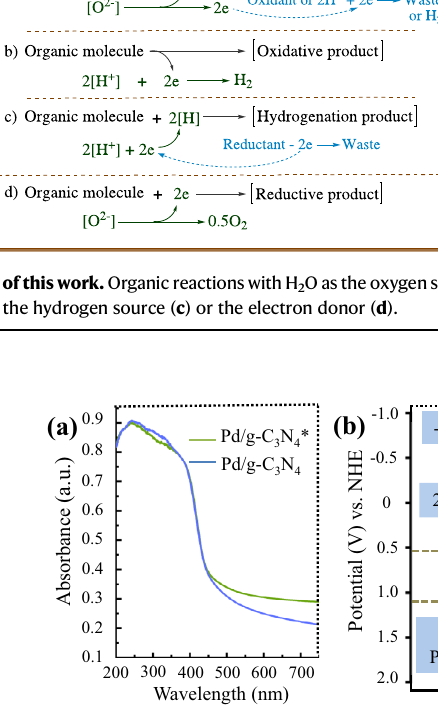
b Energy-bandpositionsof Pd/g-C 3 N 4 (blue,2.8wt%)and Pd/g-C 3 N 4 *(green, 2.8wt %). c Rationaleforconversionof Pd II toPd 0 .Pd/g-C 3 N 4 *:theactivated Pd/g-C 3 N 4 by the light-irradiated